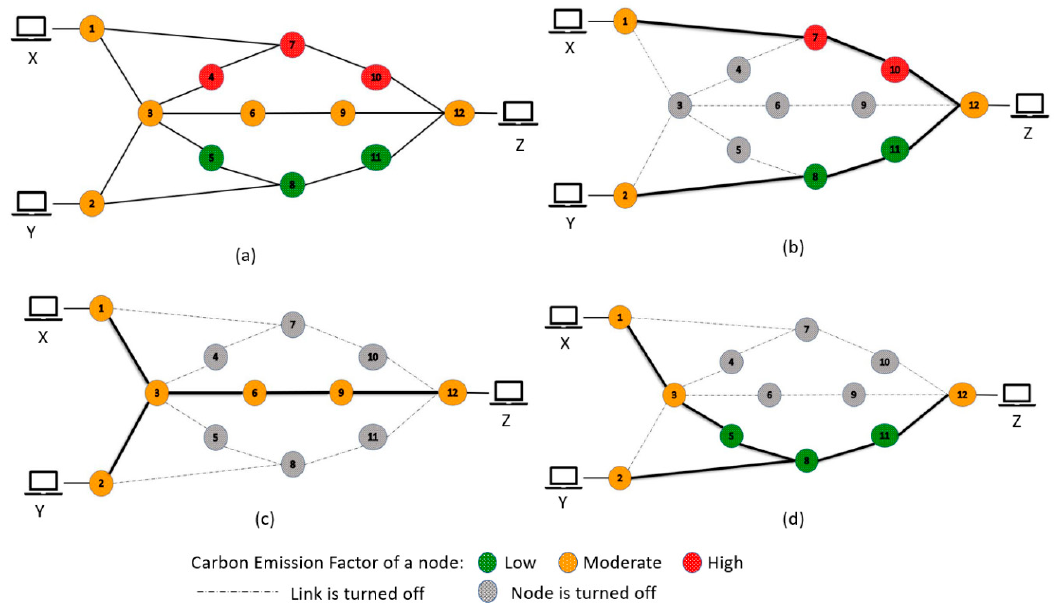
Figure 3. Example of SPF, EAR and